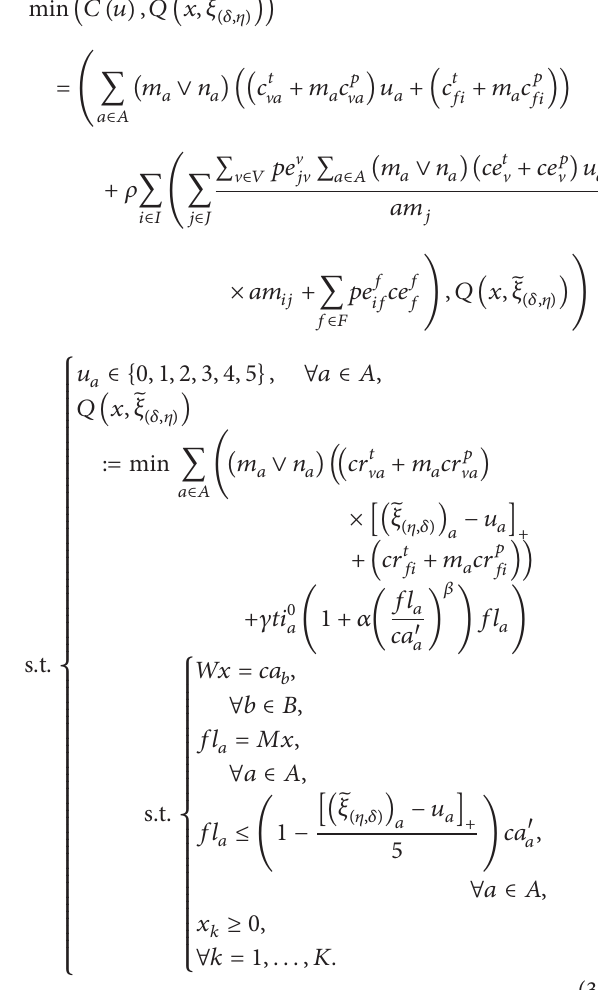
̃ 𝜉 to (𝛿, 𝜂) -level trapezoidal fuzzy variable